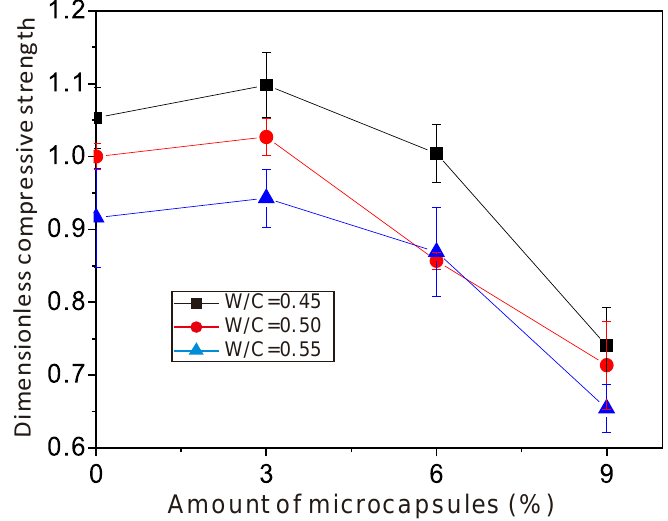
Figure 6. Variation of the compressive strength versus the amount of organic microcapsules.